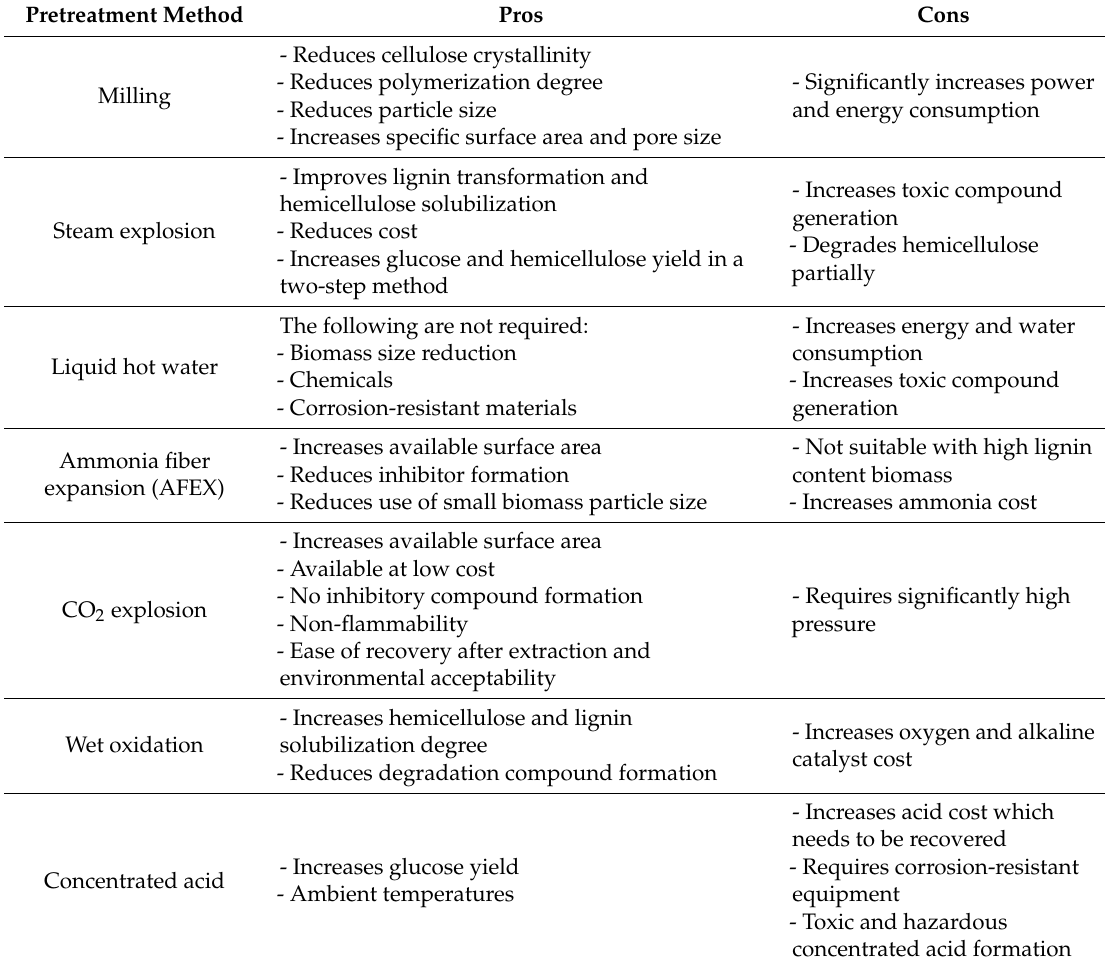
Table 1. Pros and cons of organosolv pretreatment process compared to other processes [42]. Pretreatment